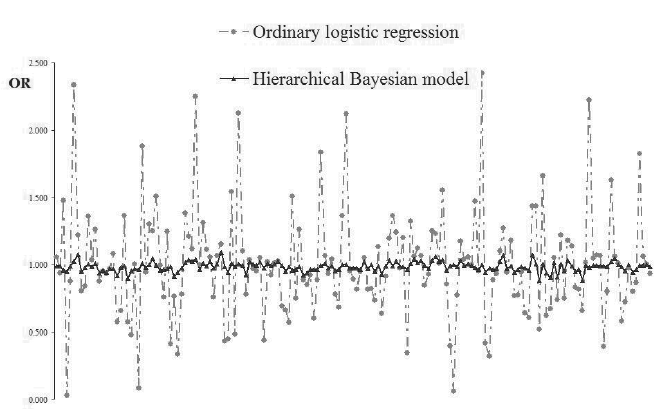
Figure 1 – Estimated